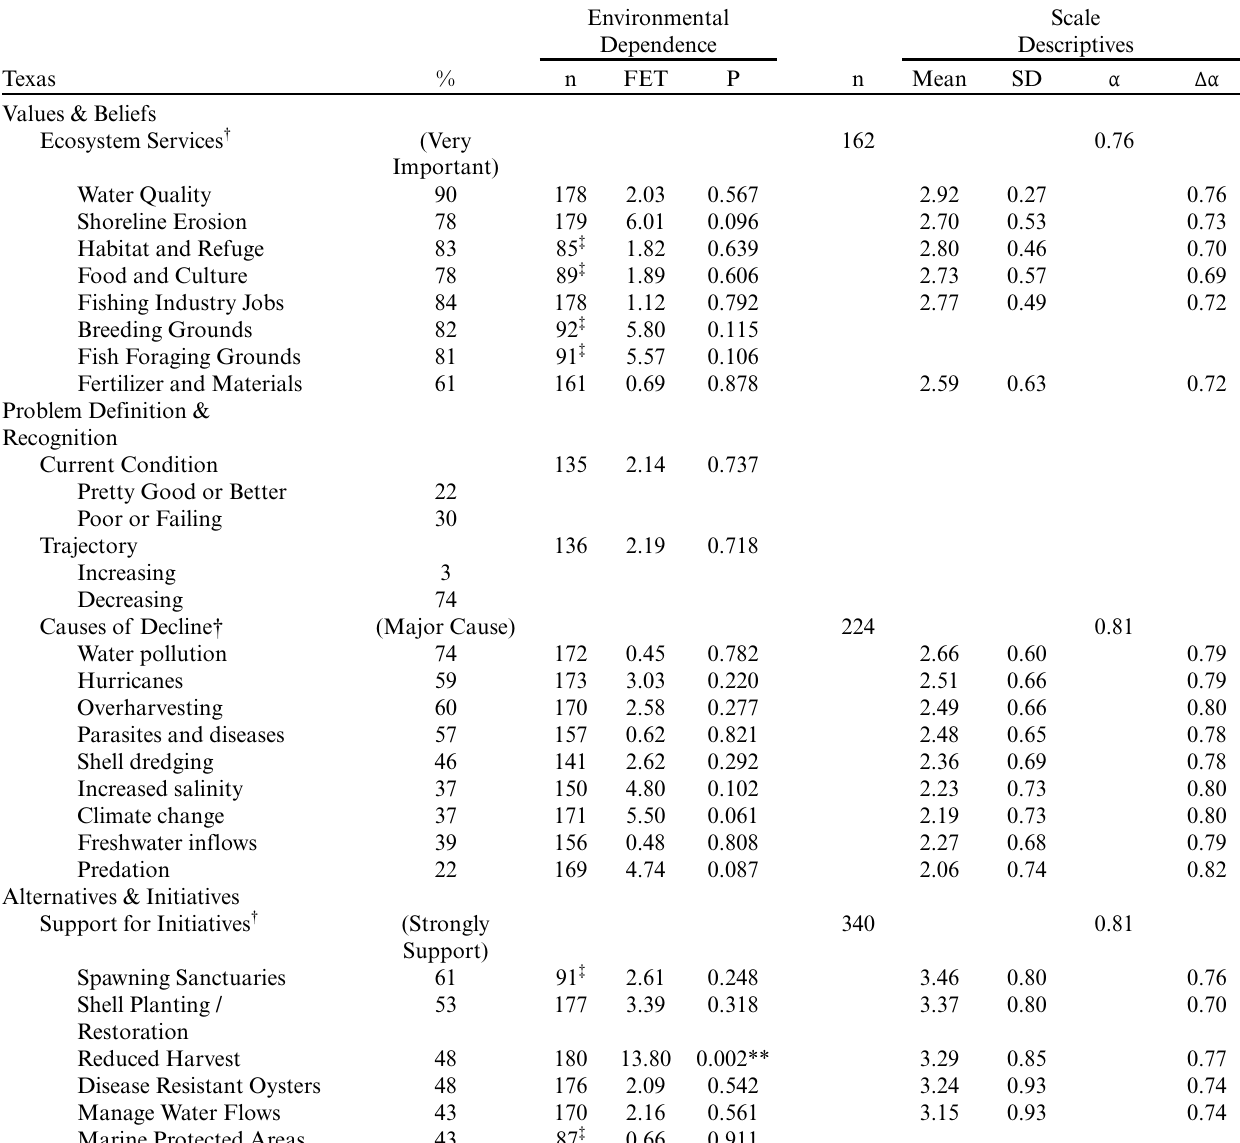
Table 4 . Scale descriptives and results of Fisher’s Exact Tests (FET) on environmental dependence for Texas.